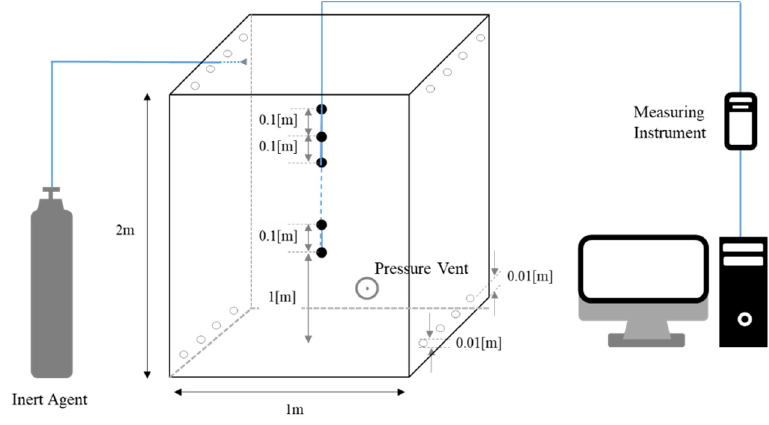
Figure 5. Schematic diagram of test enclosure and measuring equipment.